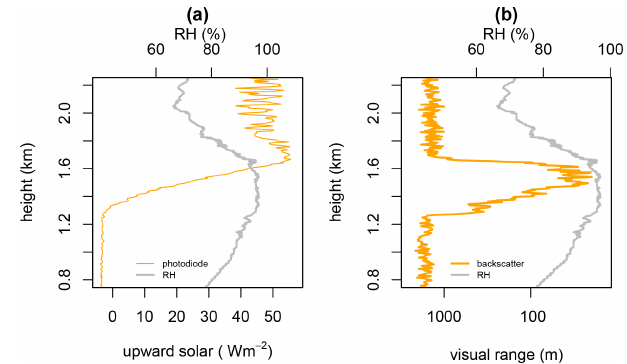
Figure 10. Sounding of a cloud layer from Reading on 22 April 2014. (a) Solar radiation from a downward-pointing photodiode was recorded (thin orange line) simultaneously with (b) the received backscattered light from ultra-bright yellow light-emitting diodes (thick orange line), expressed in terms of equivalent visual range. The relative humidity (RH) profile (thick grey line) is shown on both plots. (Adapted from Harrison and Nicoll,